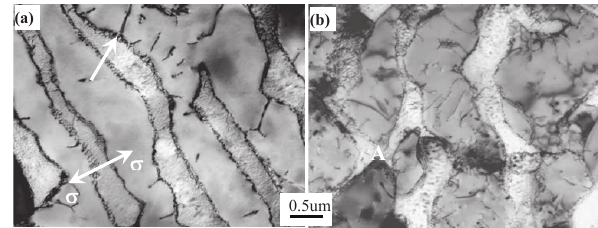
Figure 7. Morphology after alloy 2 crept for 106h up to fracture at 1313 K = 137 MPa. (a) Twist of the rafted (cid:2) 0 phase, (b) dislocations shearing into the rafted (cid:2) 0